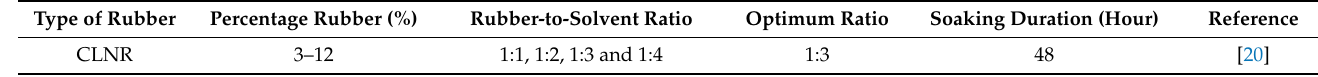
Table 2. Xylene application method based on previous